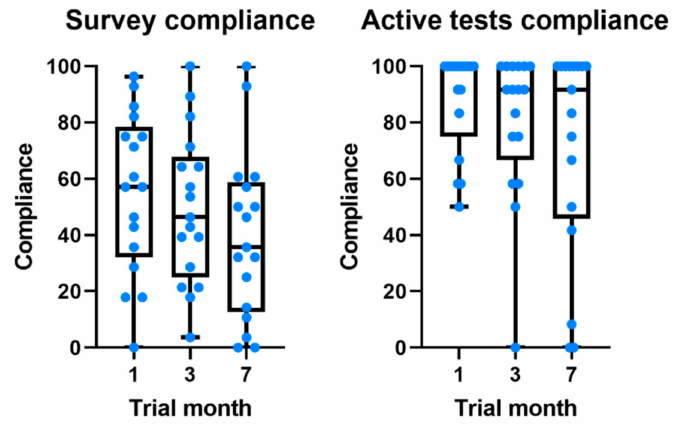
Figure 3. Boxplots comparing the evolution of compliance throughout the study for daily survey and active